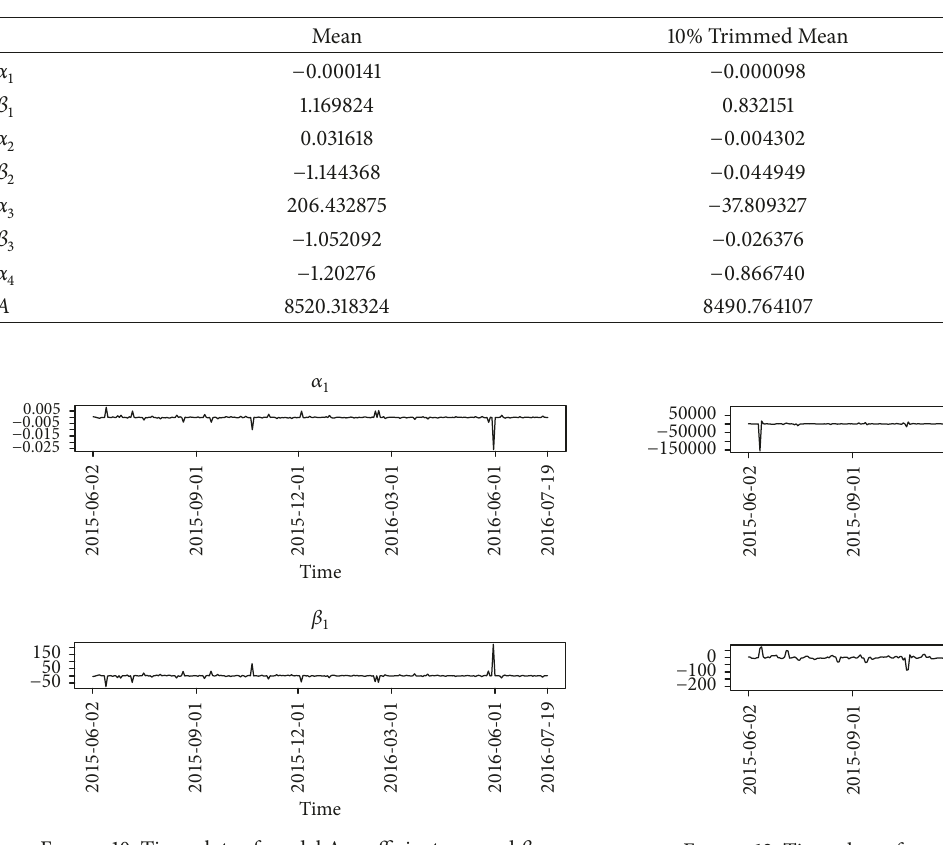
Figure 12: Time plots of model C coefficients- 𝛼 3 and 𝛽 3 .